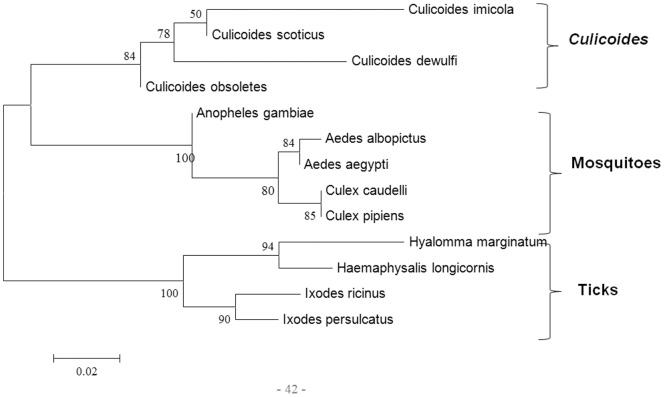
Maximum likelihood trees showing phylogenetic comparisons of the amino acid of cytochrome oxidase I (COXI) of arthropods.ML tree of COXI of 3 groups of arthropods which transmit orbiviruses (ticks, mosquitoes and Culicoids). The scale bar represents the number of substitutions per site.